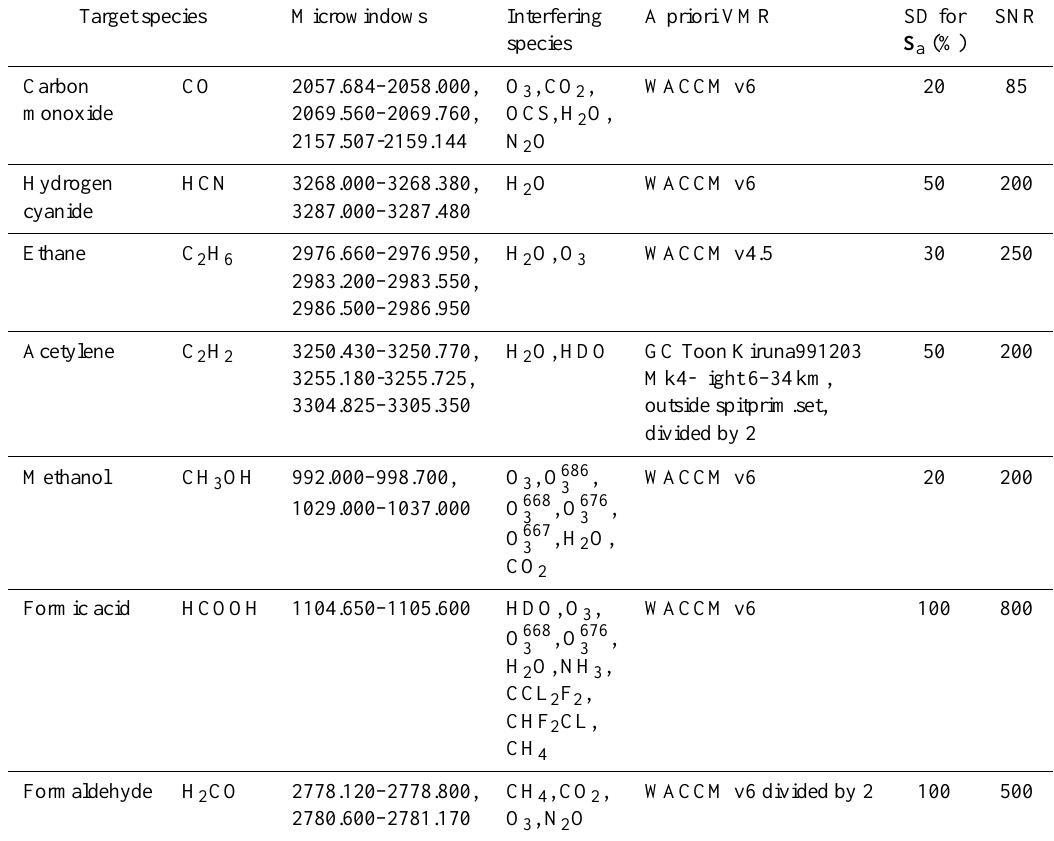
Table 2. Parameters (microwindows, interfering species, a priori VMR sources, standard deviations – SD – of the a priori covariance matrix and signal-to-noise ratios – SNR) used in the retrievals of the seven target